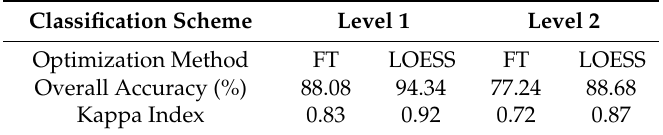
Table 5. Overall accuracies (OA) for two levels using different segmentations as